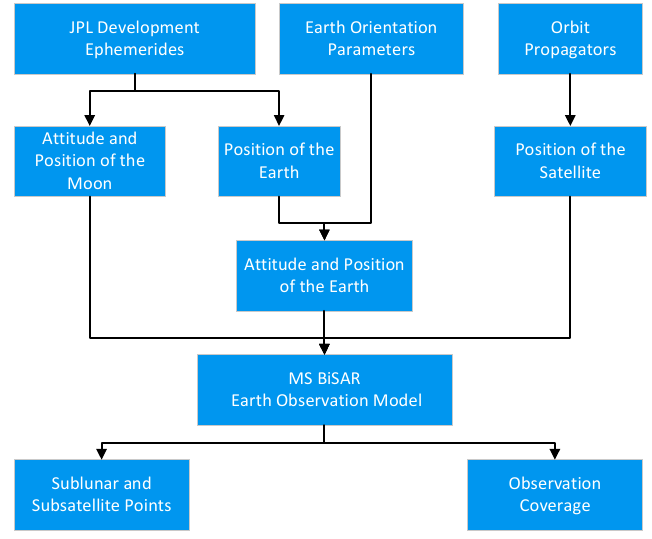
Figure 2. The main work content and steps of this paper.